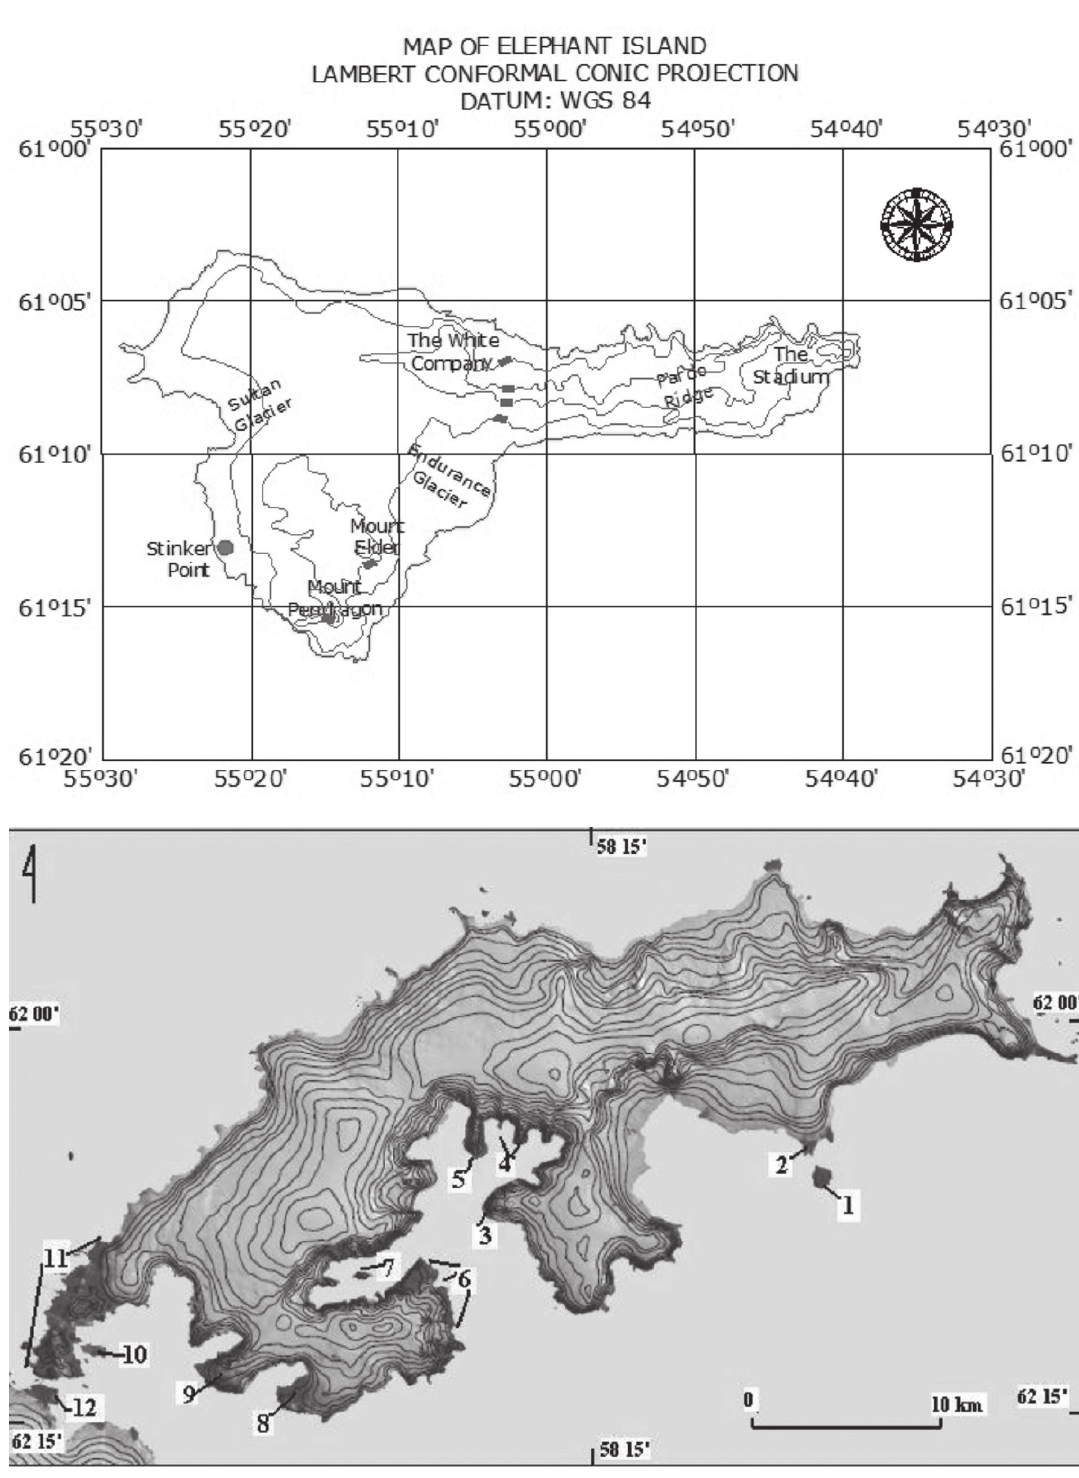
Figure 1 – Maps of Islands visited by the group: Elephant island (upper part), King George and Nelson Islands (middle) and Deception Island (down). 1 – Penguin Island. 2 – 11 King George Island: 2- Turret Point; 3- Hennequin point; 4-Ullman Point and Stenhouse Bluff; 5- Keller Peninsula; 6- Region from Thomas Point to Telefone Point; 7- Dufaiel Island; 8- Potter Peninsula; 9- Barton Peninsula; 10- Ardley Island; 11- Fildes Peninsula; 12 – Nelson Island (Rip